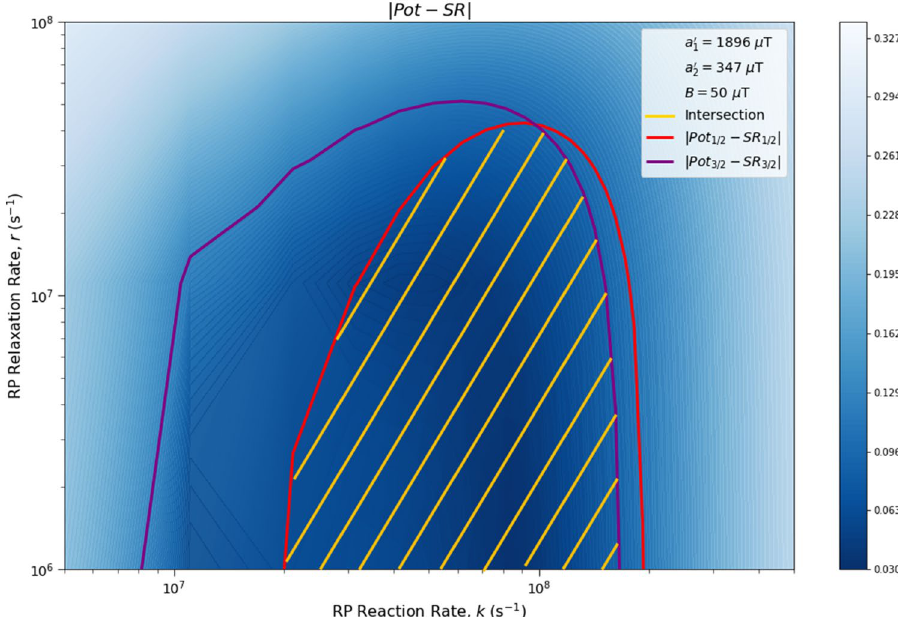
Figure 7. The dependence of the agreement between relative anesthetic potency and singlet yield ratio on the relationship between r and k for r ∈ [ 1.0 × 10 6 , 1.0 × 10 8 ] s − 1 and k ∈ [ 5.0 × 10 6 , 5.0 × 10 8 ] s − 1 , using a ′ 1 = 1896 µ T, a ′ 2 = 347 µ T, and B = 50 µ T. The singlet yield ratio SR is calculated using a a ′ 1 = (γ n / | γ 129 Xe | )γ e 1 , where the magnitude of the isotopic nuclear gyromagnetic correction factor, (γ n / | γ 129 Xe | ) , is normalized for 129 Xe. The model can explain the experimentally derived 6 relative anesthetic potency of xenon where | Pot 1 / 2 − SR 1 / 2 | ≤ 0.08 and | Pot 3 / 2 − SR 3 / 2 | ≤ 0.08 intersect, shaded in